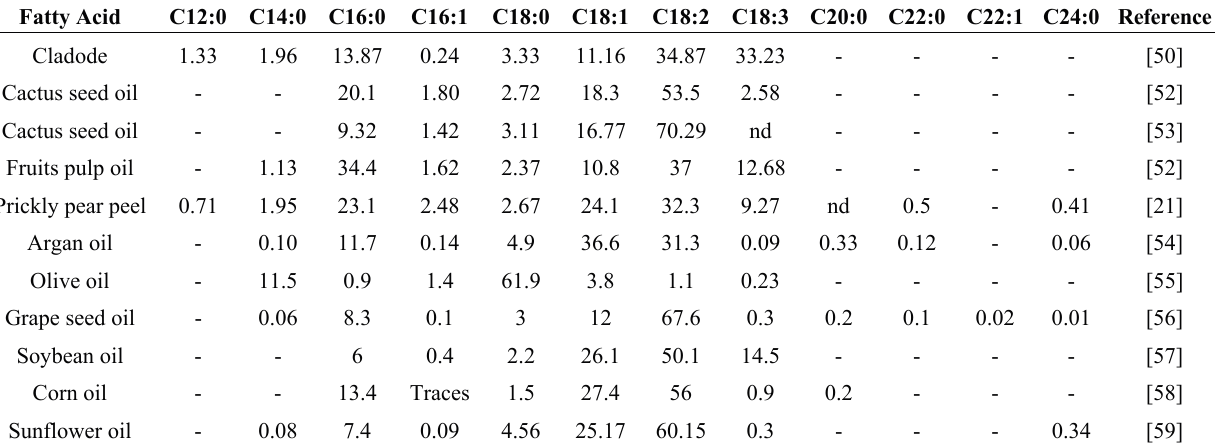
Compositions are expressed in g/100 g fatty